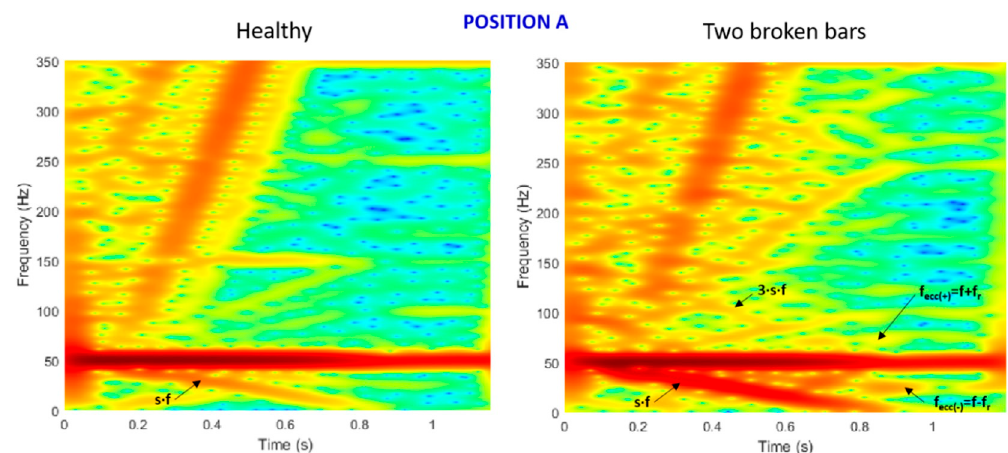
Figure 6. Time-frequency maps of the electromotive force (emf) signals induced by the stray flux at sensor position A for the two considered fault conditions.